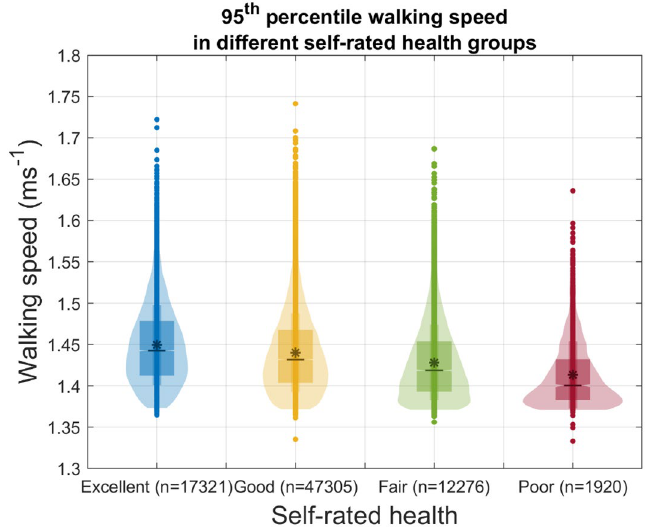
Figure 5. Maximal walking speed for people who reported poor, fair and good and excellent health. N = 78,822. Individual dots at the upper and lower extreme, raw data outliers. Widths of the violin plots, kemel desnsities; Top and bottom of the violin plots, 1st and 99th percentiles; Top and bottom of the narrower boxs, mean ± standard deviation; Top and bottom of the widers box, 1st and 3rd Quartile; Notches of the wider box, 95% confidence intervals of the population median; Black lines in the middle of the boxs, group medians; The asterisks in the middle of the boxes, group means. ms − 1 metre per